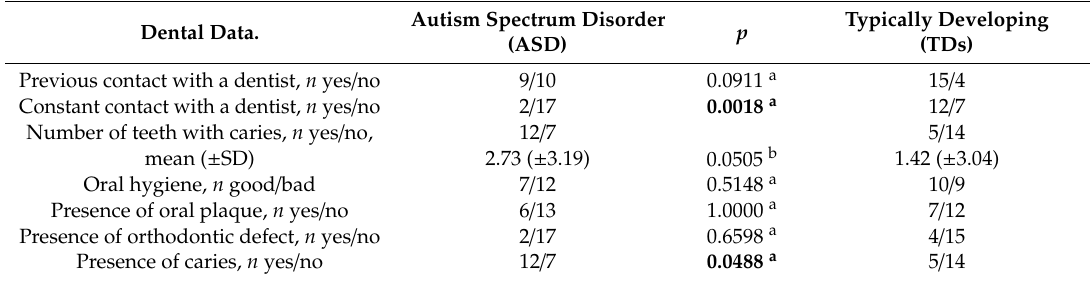
Table 3. Detailed characteristics of clinical parameters from the dental examination in Autism spectrum disorder (ASD) and typically developing (TD)